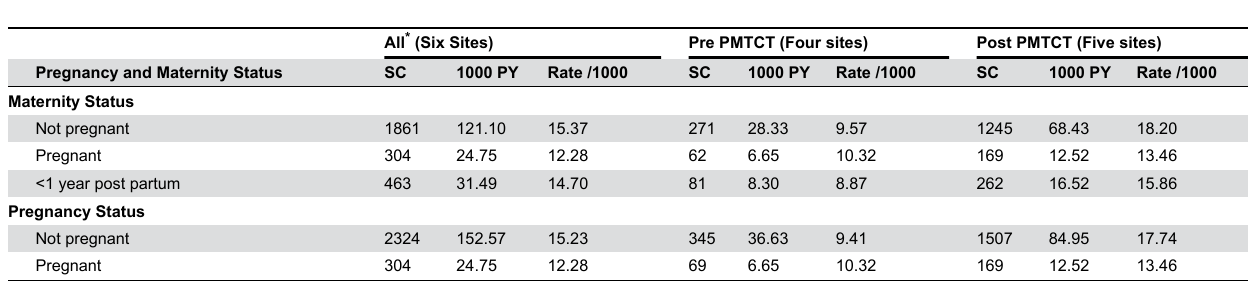
Table 2. Sero-conversion and person years contributing to the analysis for each period (mean of imputation runs).